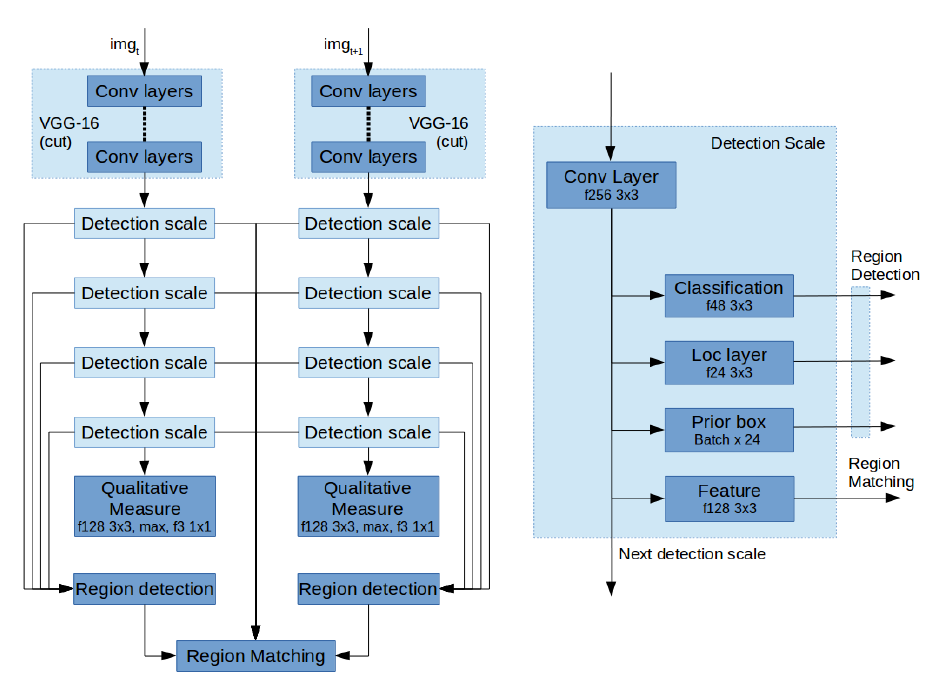
Figure 6. ( a ) Left: Detection network architecture; ( b ) Right: Architecture of a single detection